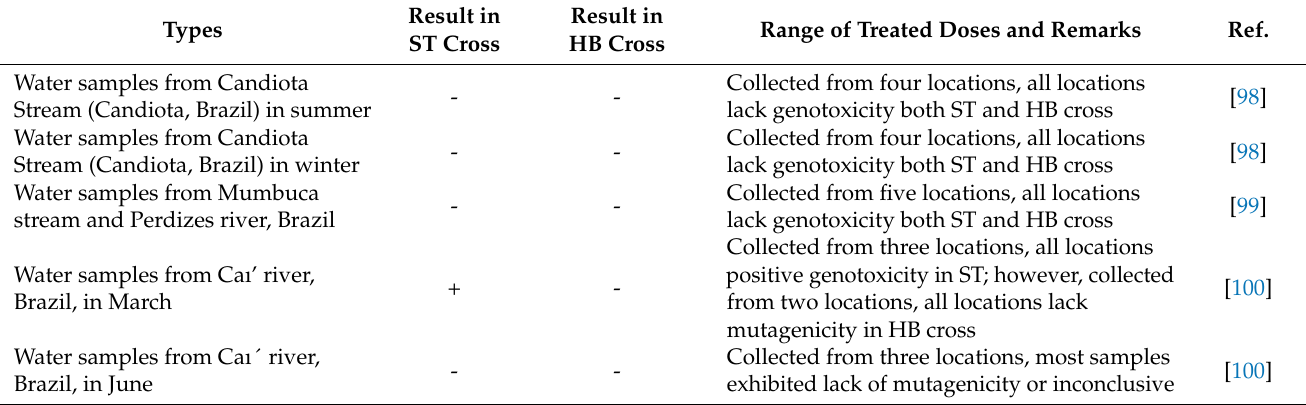
Table 5. Applications of SMART for testing